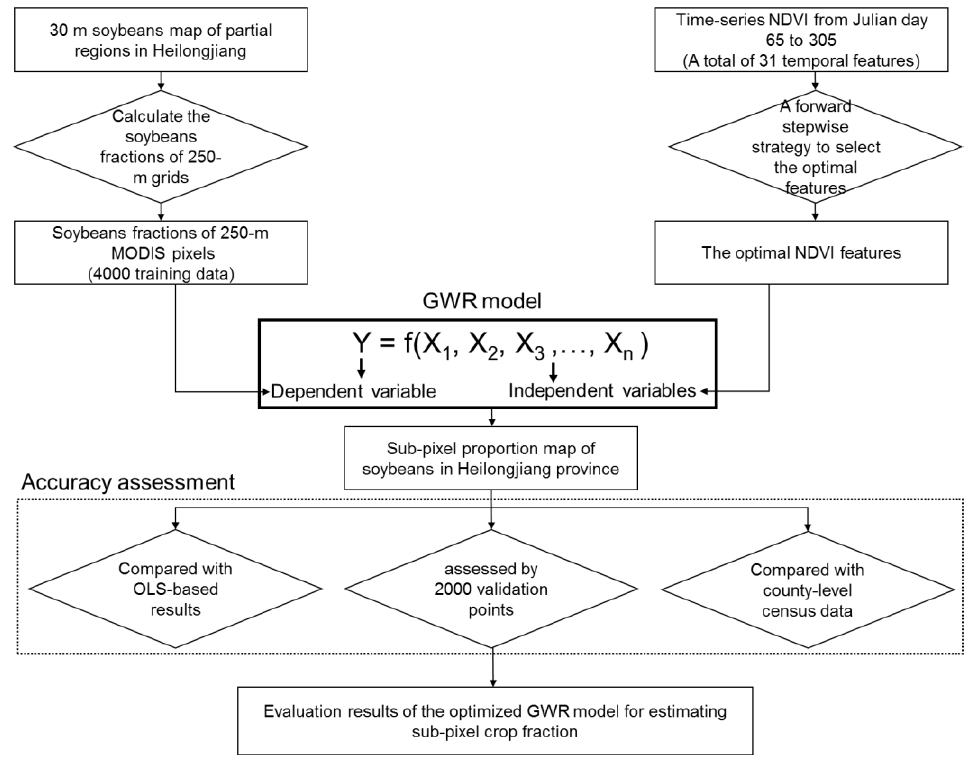
Figure 3. Overview of the optimized GWR model for estimating the sub-pixel soybean fractions and the evaluation methods. The equation of GWR here is simplified and the detailed equation of GWR and associated parameters are described in Section 3.1.1.